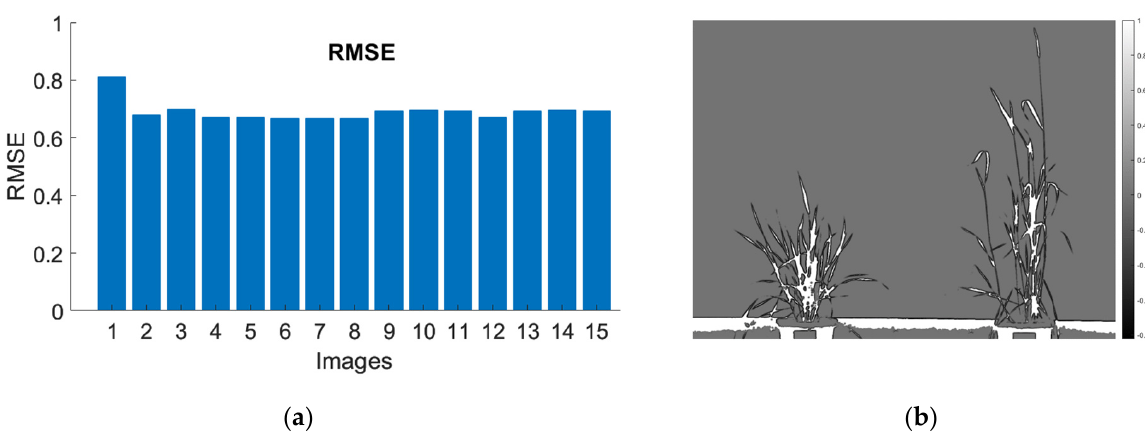
Figure 15. Error metric for segmentation: ( a ) Root Mean Square Error (RMSE) and ( b ) Structural Similarity Map (SSIM) between the original image and segmented images.